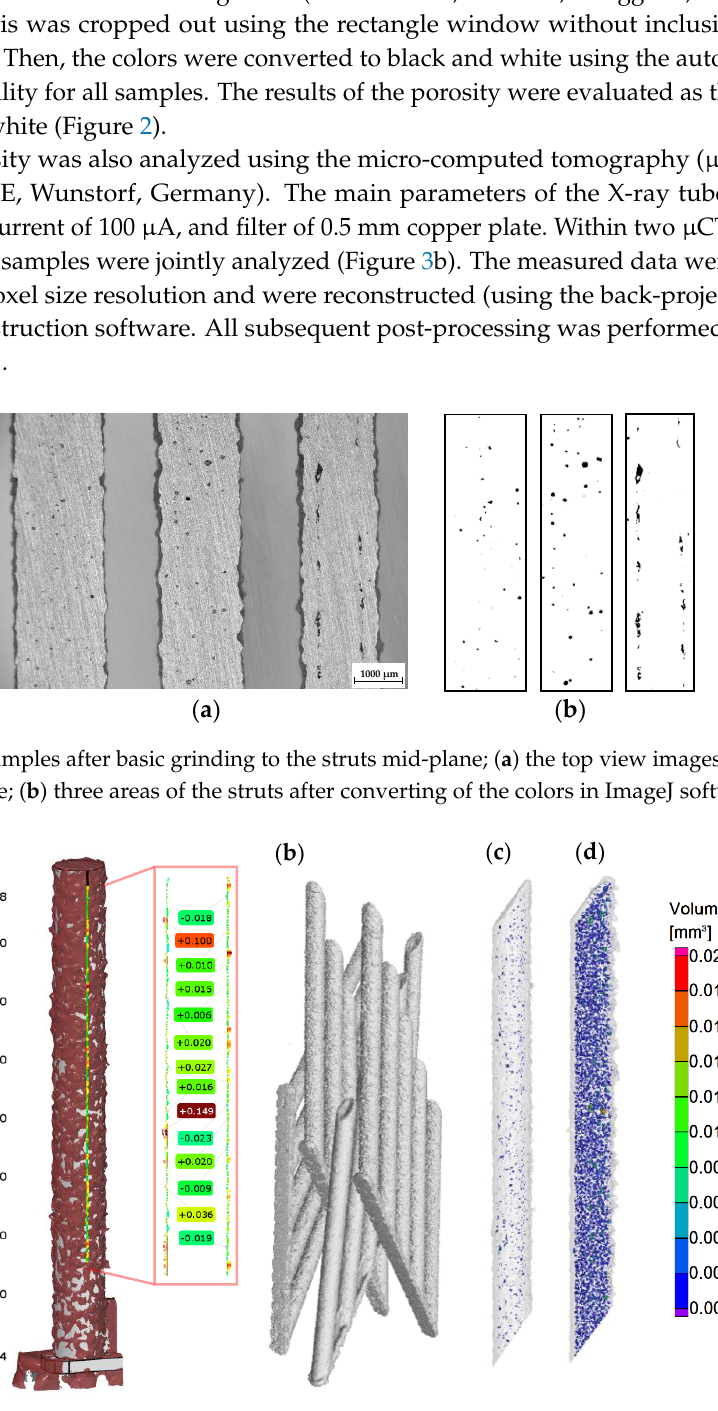
Figure 3. Struts analysis—( a ) surface roughness evaluation in GOM Inspect software after optical measurement; ( b ) group of four samples measured together in VGStudio MAX software; ( c ) transparent 3D render of the strut with the lowest porosity 0.17% ( d ) transparent 3D render of the strut with the highest porosity 2.93%.